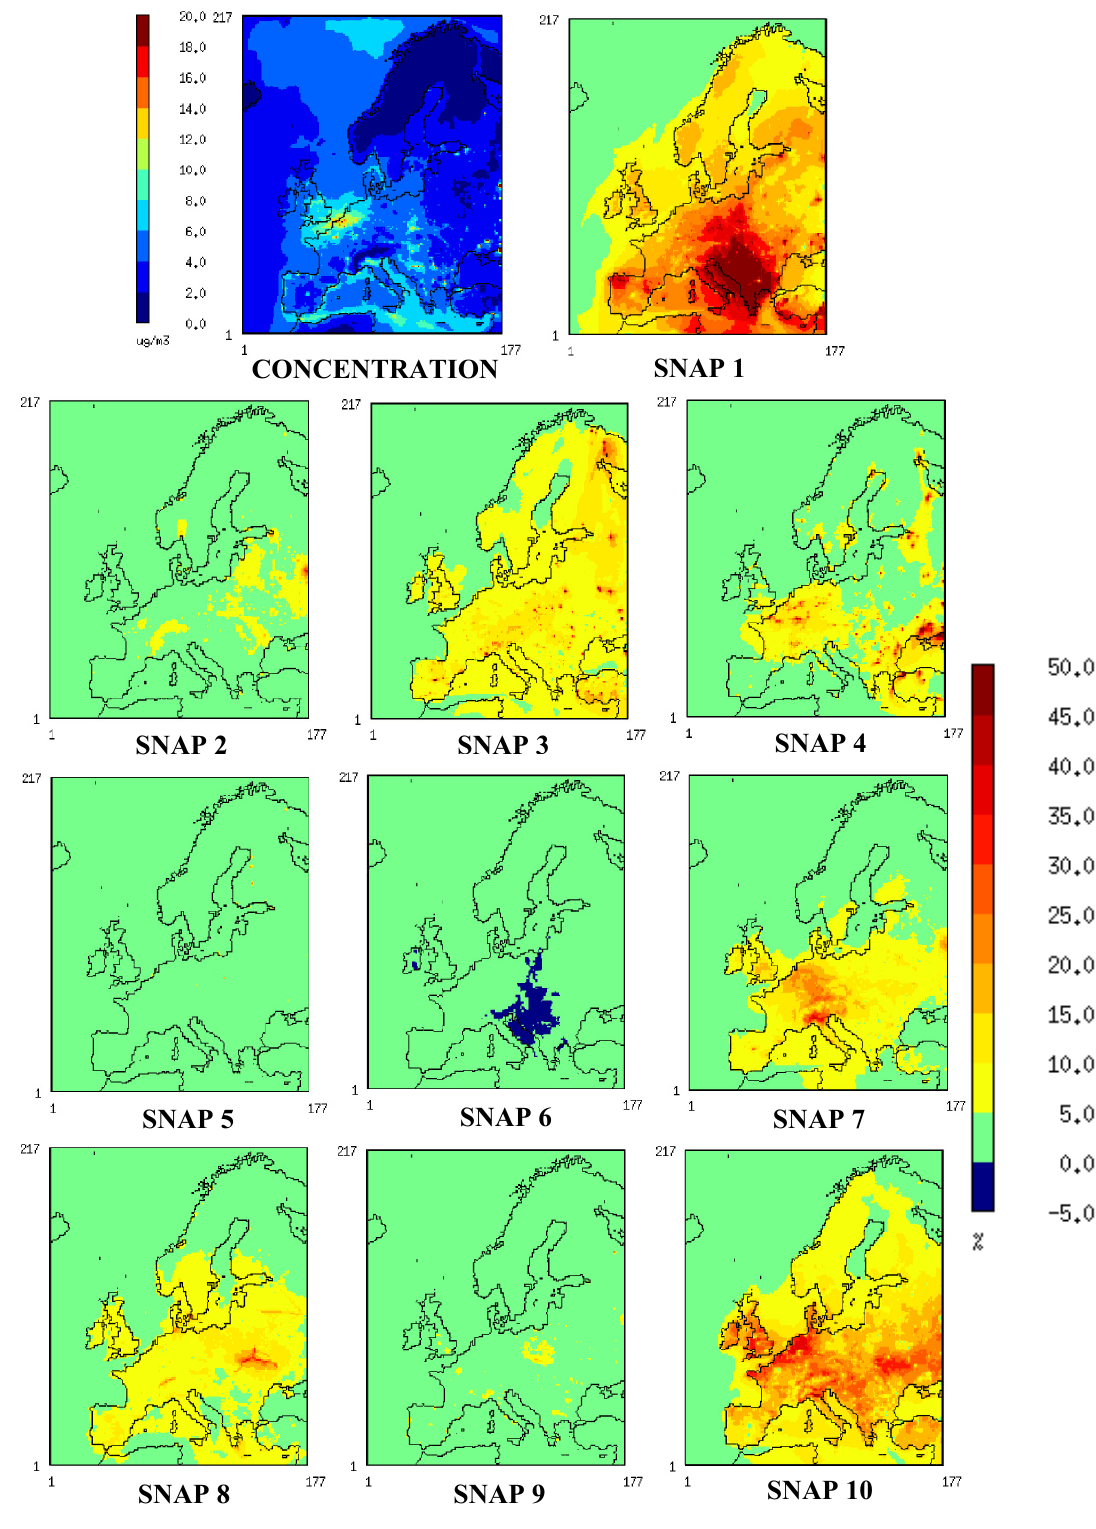
Figure 4. Daily average PM 2.5 concentration for July 2006 and the impact of each SNAP